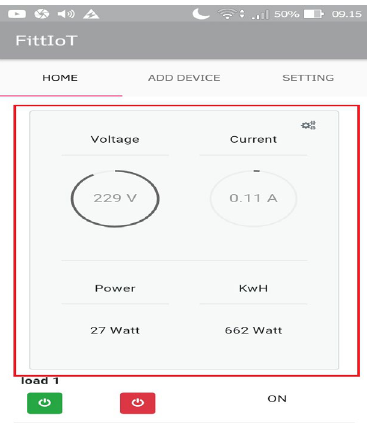
Figure 6. Remote control testing